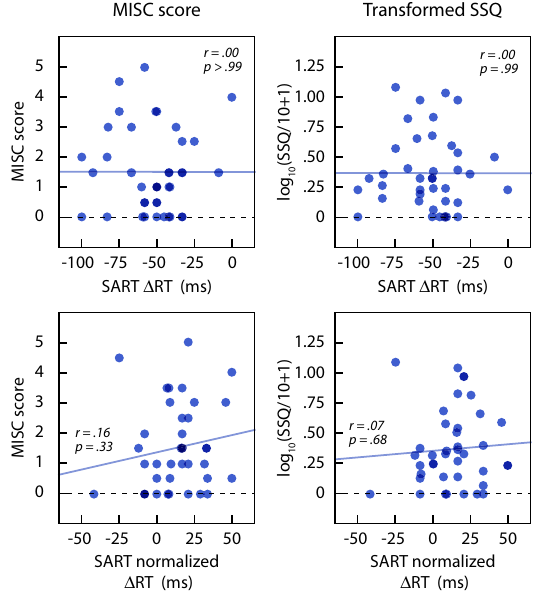
Fig. 11 Cybersickness experienced by individual subjects during virtual navigation in Experiment 2 plotted as a function of their attentional allocation scores. The two rows use different measures of attentional allocation: the mean difference in reaction times for central and peripheral targets with coherent background motion (top row), or the mean difference after normalizing for reaction times in the incoherent motion conditions (bottom row). Positive values of ΔRT correspond to more attention to the periphery. Lines show the regression fits. The left graph plots the MISC scores and the right graph plots the SSQ scores after transforming by log 10 (SSQ/10